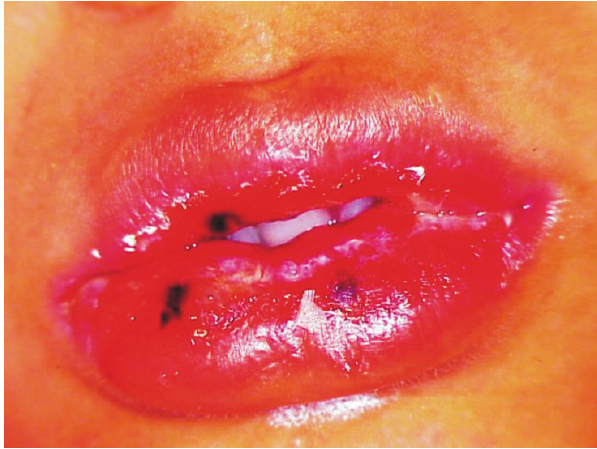
Figure 1 - Chemotherapy induced oral mucositis